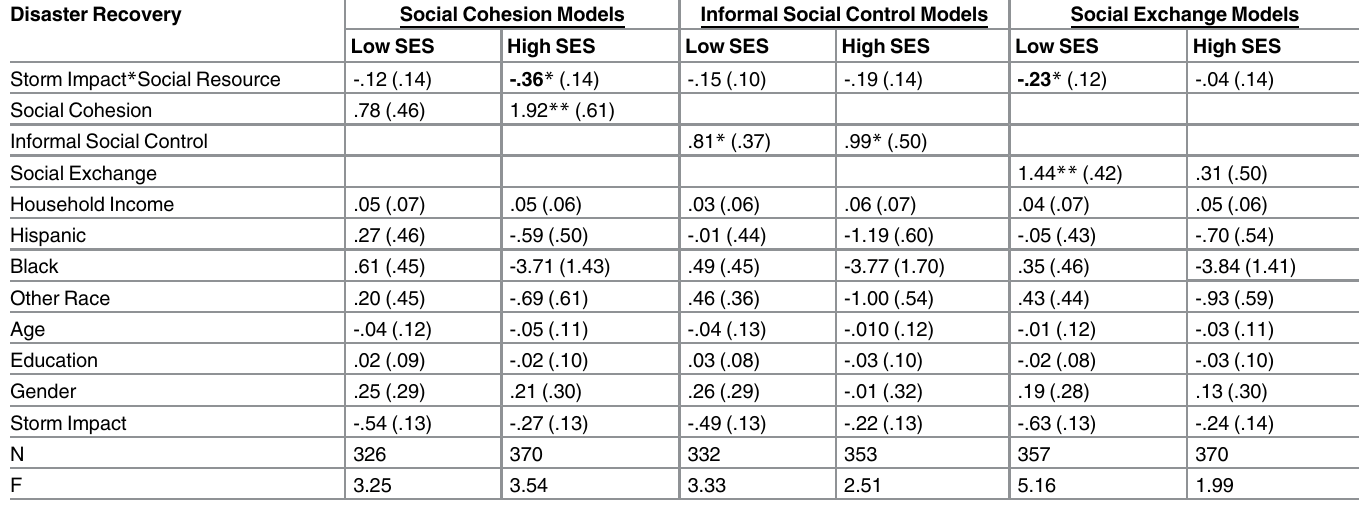
Table 7. Social resources and their associations with beliefs about recovery from future disasters for low and high SES